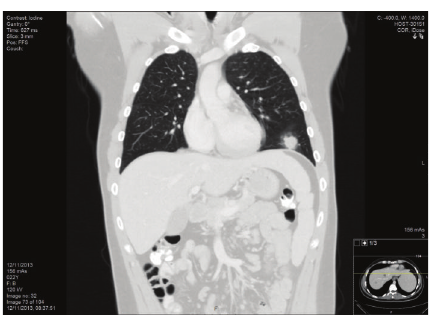
Figure 1: Coronal reconstruction of thoracic CT scan in lung window irregular pulmonary nodule with surrounding ground glass opacity in the left lower lobe of the